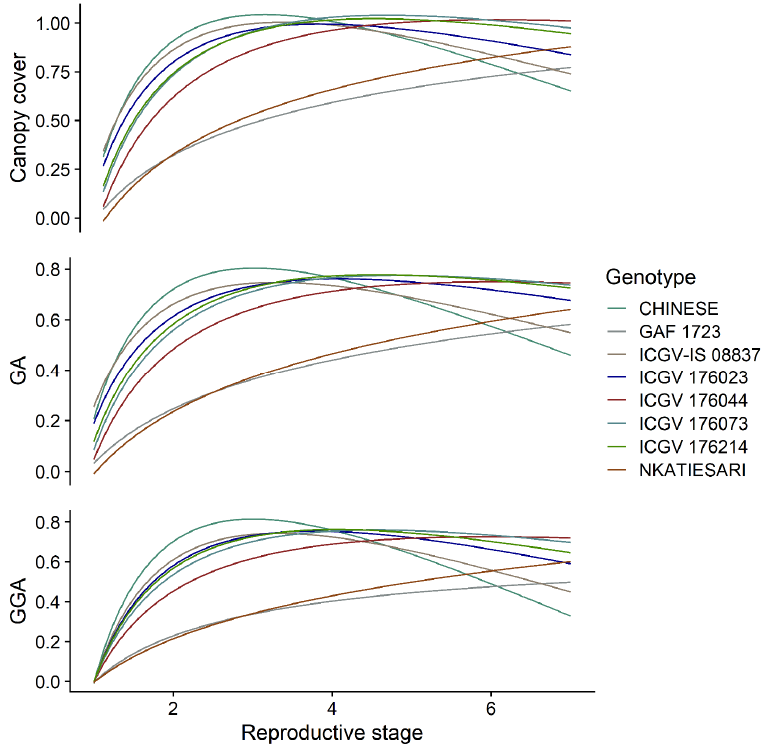
Figure 3. Canopy cover, green area (GA) and greener area (GGA) of selected medium duration (MD) and short duration (SD) genotypes.